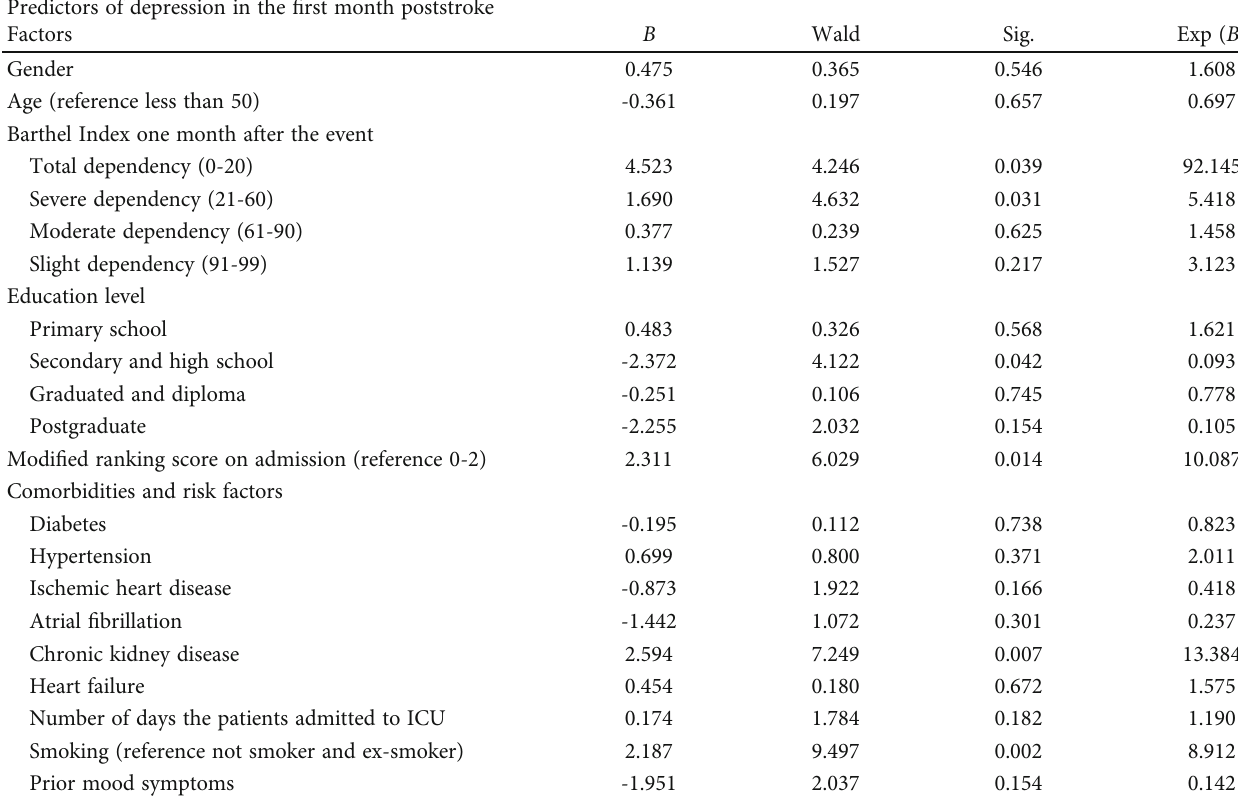
Table 6: Predictors of depression after one